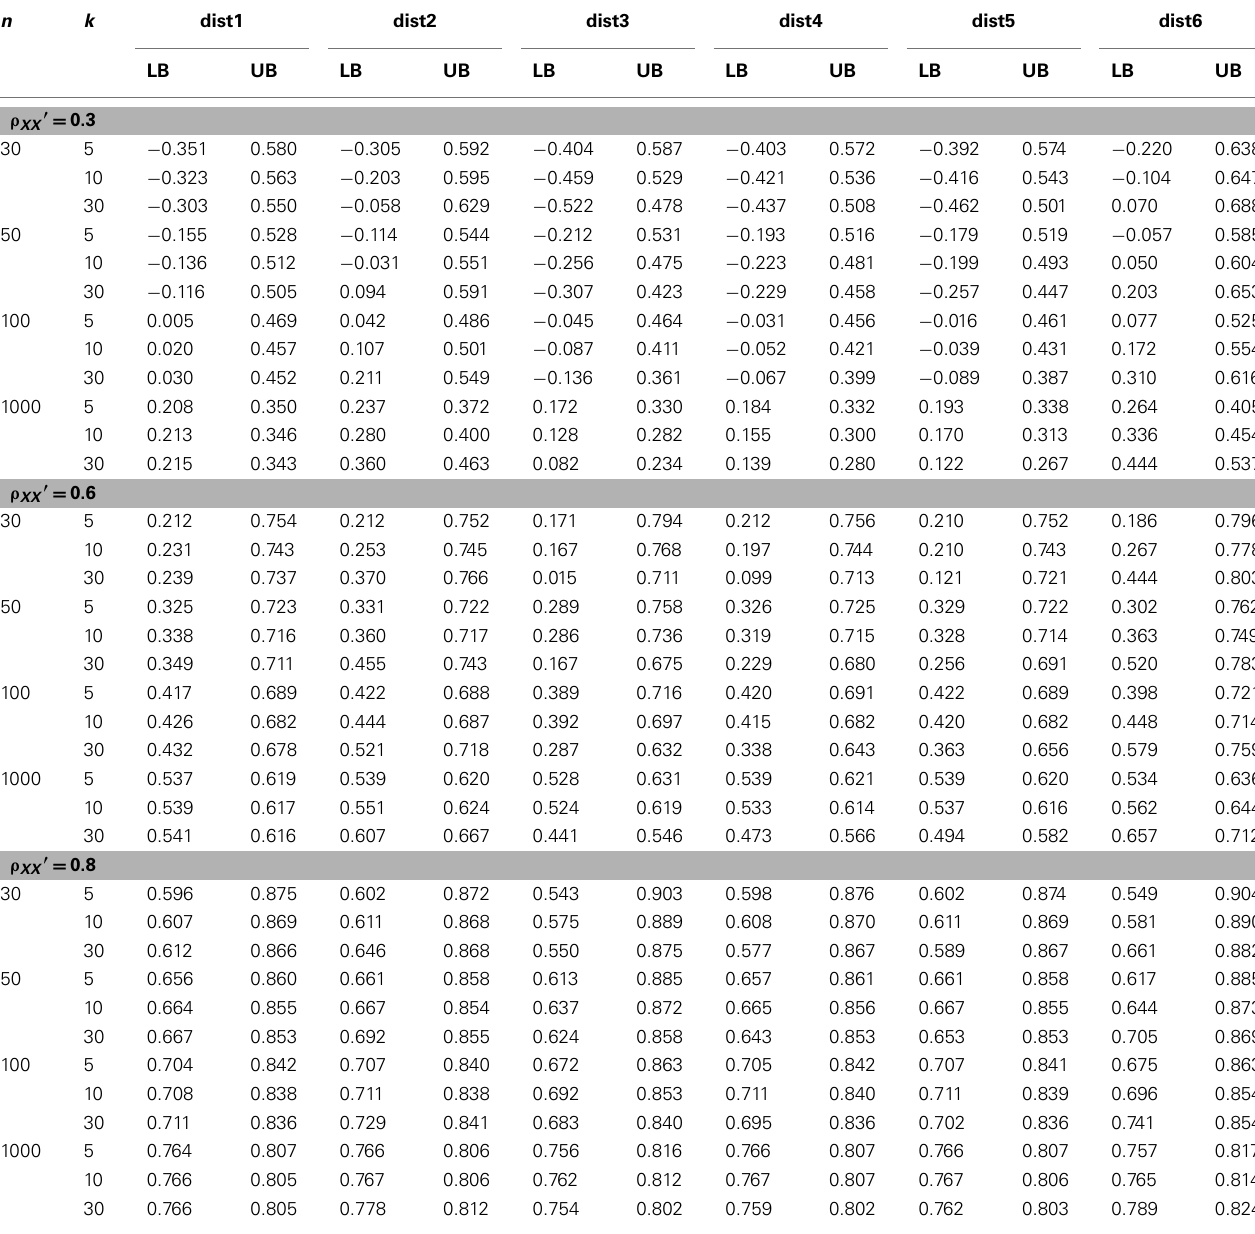
Table 6 | Observed 95% interval of the sample alpha ( ˆ α ) for the simulated situations where the error score ( e ij ) distribution is normal or